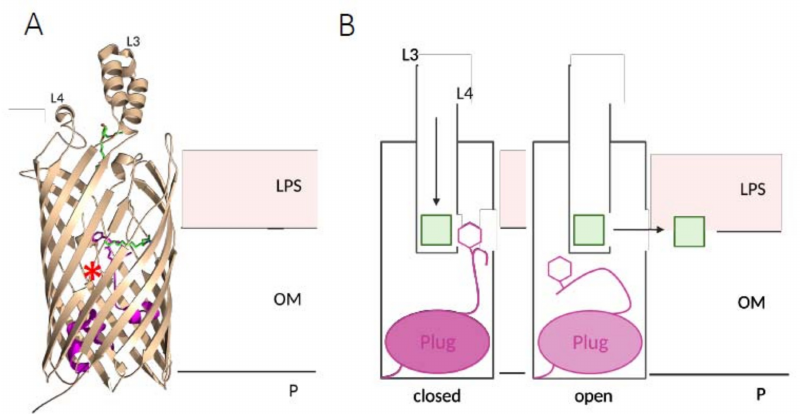
Figure 2. ( A ) FadL structure. The extracellular loops L3 and L4 are indicated. The N-terminal hatch domain (the plug, in panel B ) and the phenylalanine 3 (the hexagon) are in pink. Two fatty acid molecules are shown in green, in the different binding sites: the low-affinity binding site at the entrance of the channel (on the top) and the high-affinity binding site in the channel (on the bottom). The red star shows the lateral opening in the β -barrel. ( B ) Model for ligand-gated transport in FadL. This model has been proposed in [9]. FadL is depicted as the black rectangle. In the closed state ( left ), the LCFA substrate (green square) binding to the high-affinity site in the channel causes a conformational change in the N-terminal hatch domain. The resulting displacement of the phenylalanine 3 (pink hexagon) leads to the open state of FadL ( right ) and to substrate release. The LCFAs are released in the OM through the lateral opening in the barrel wall. The putative positions of the outer membrane (OM) boundaries are indicated with horizontal lines, with the lipopolysaccharide (LPS) extracellular side at the top and the periplasm (P) at the bottom. This and the following figures were made with PyMOL.